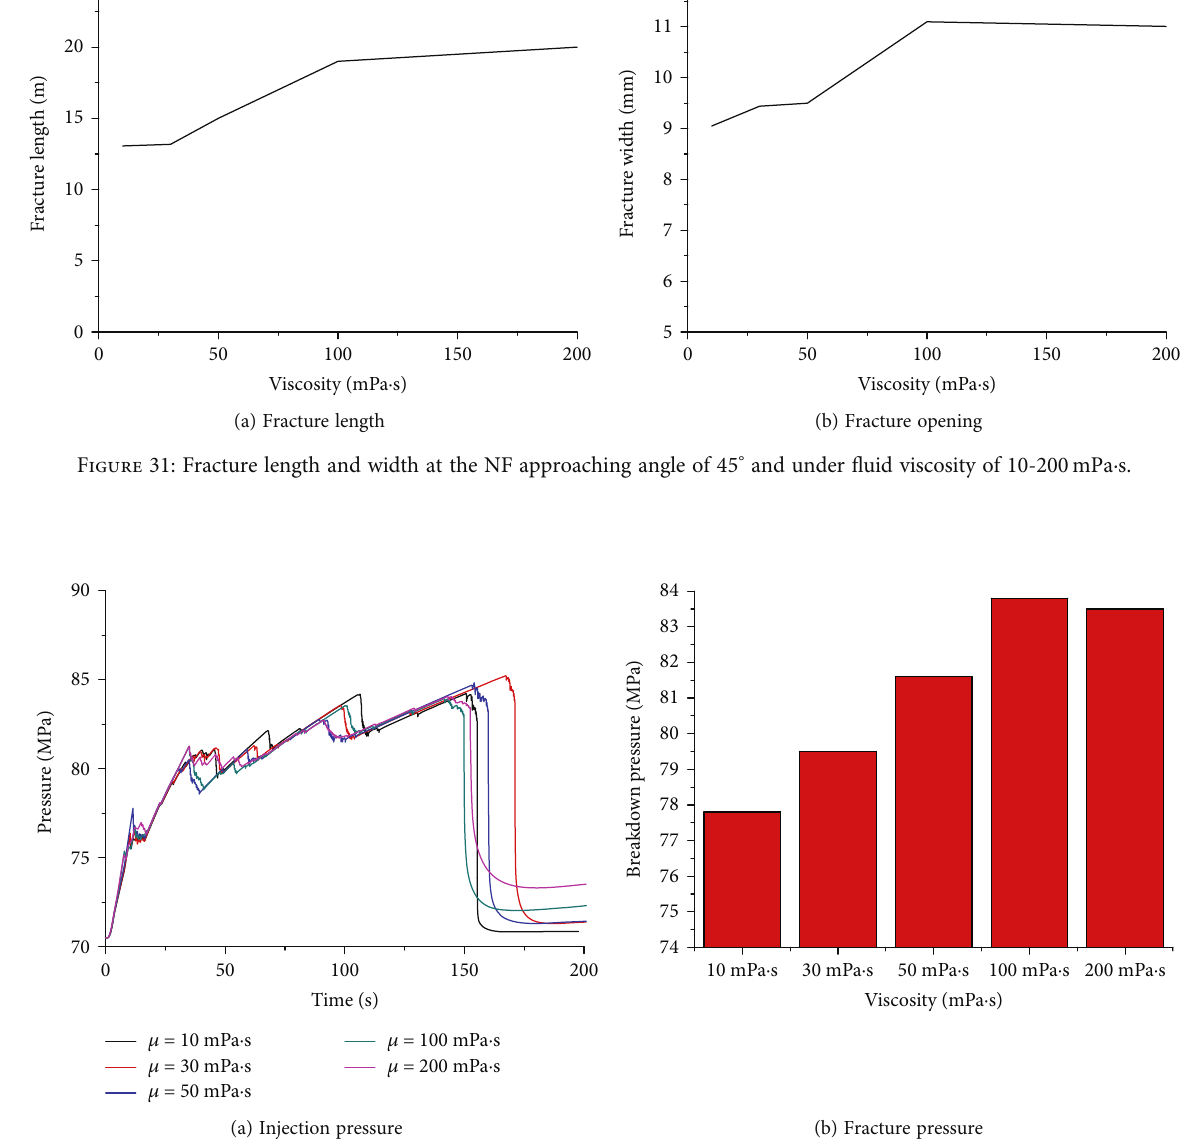
Figure 32: Injection pressure and fracture pressure at the NF approaching angle of 45 ° and under fl uid viscosity of 10-200 mPa ·